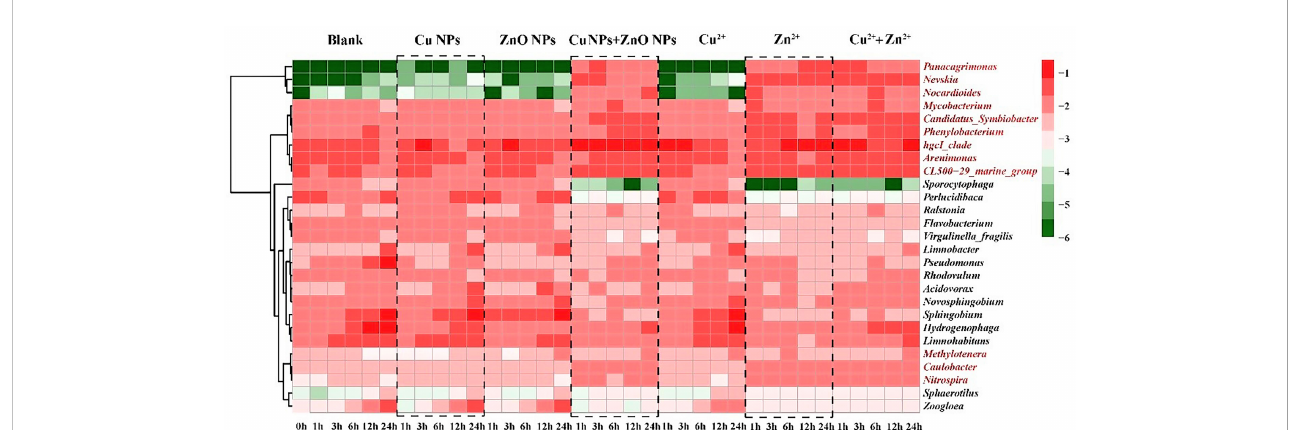
FIGURE 2 Heatmap of relative abundance of top 10 genera (values were log 10 - transformed), presenting the evolution of the microbial community in all the samples at different exposure time. The redder, the higher the values, and the bluer, the lower the values. The genera marked in red are the 12 genera with higher abundances comparing to the corresponding controls in Group